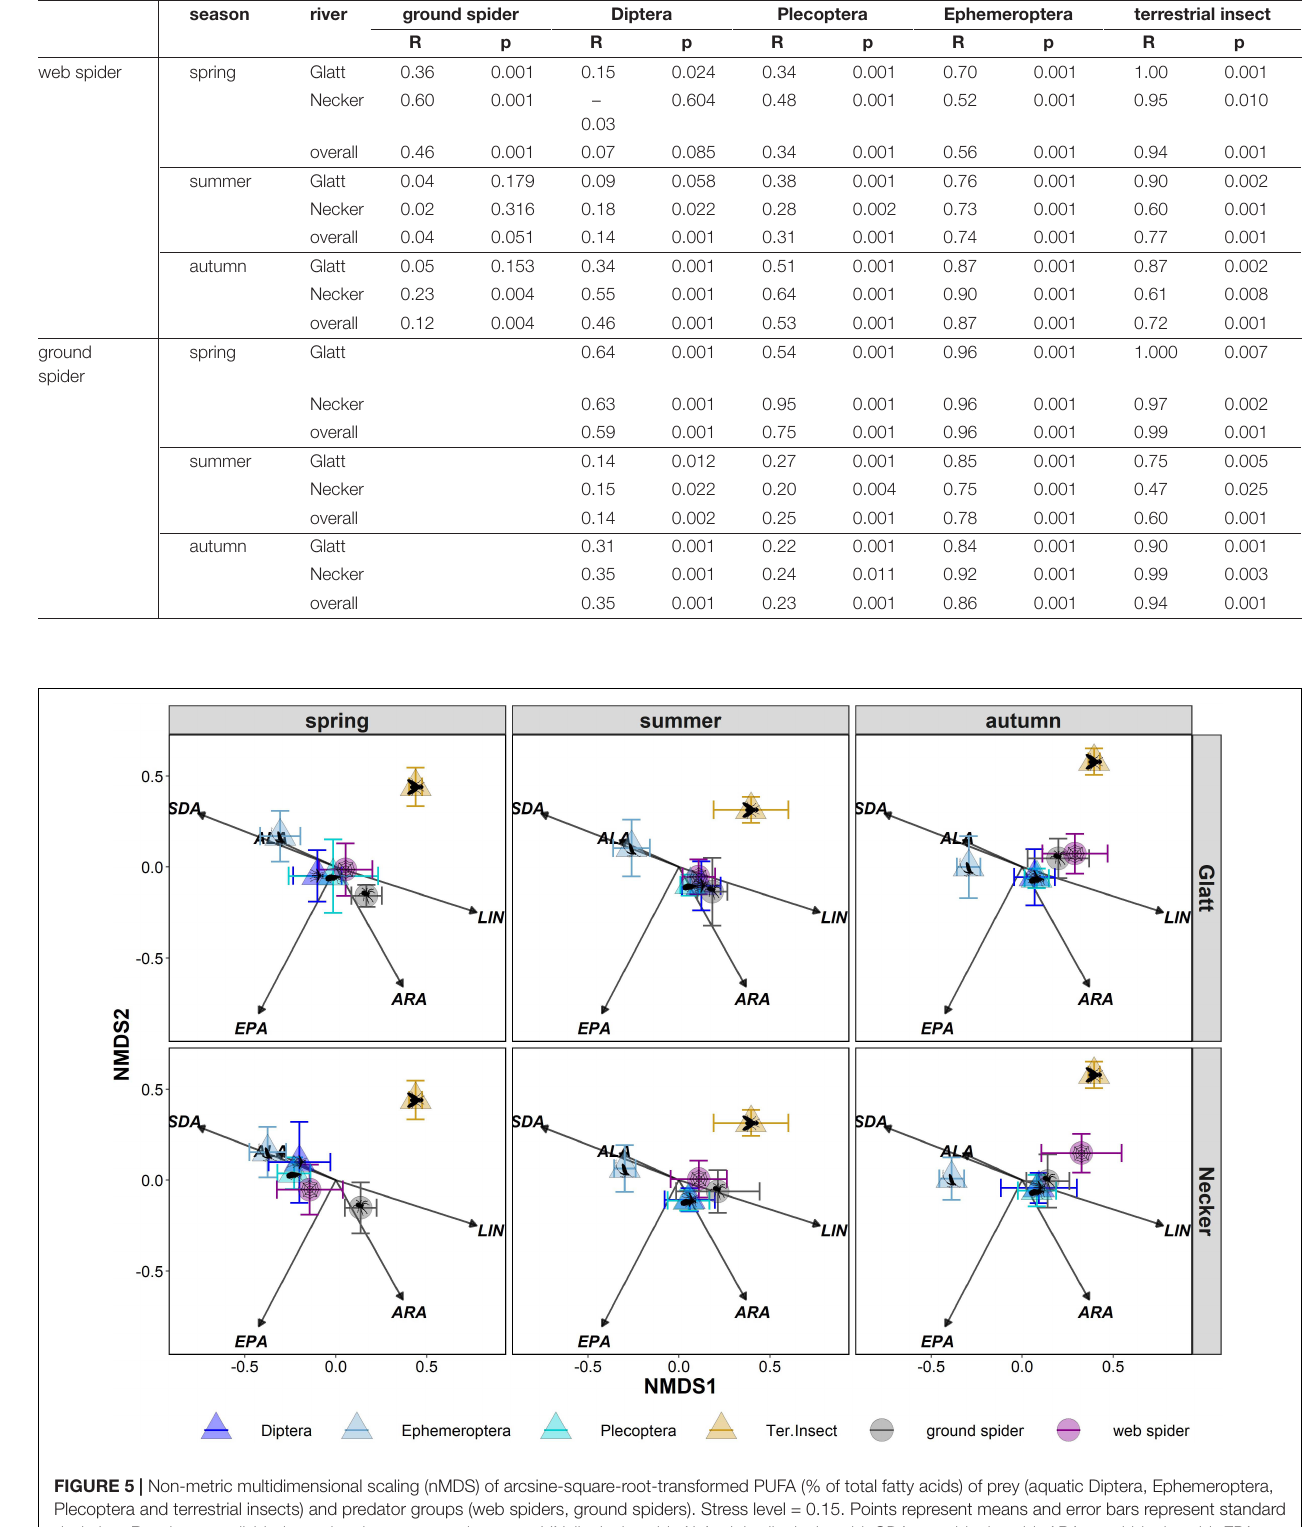
Frontiers in Ecology and Evolution |